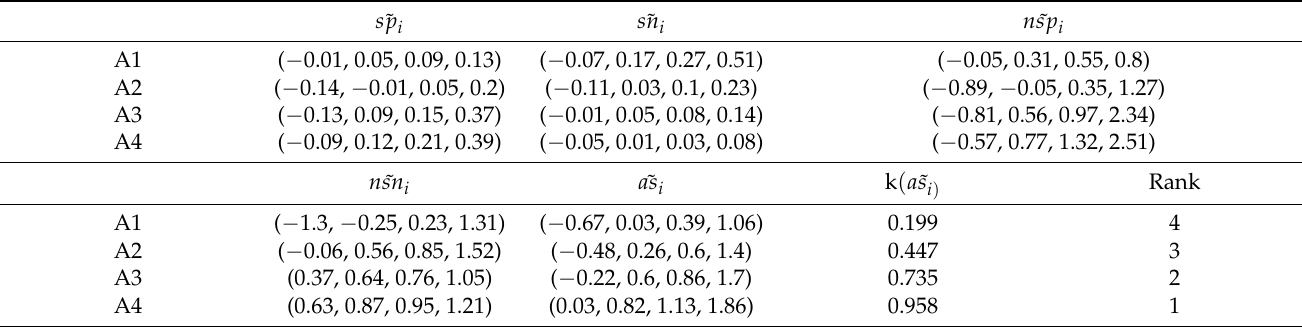
Table 8. The results of order-picking technology selection using novel IMF SWARA-Z–fuzzy EDAS-Z